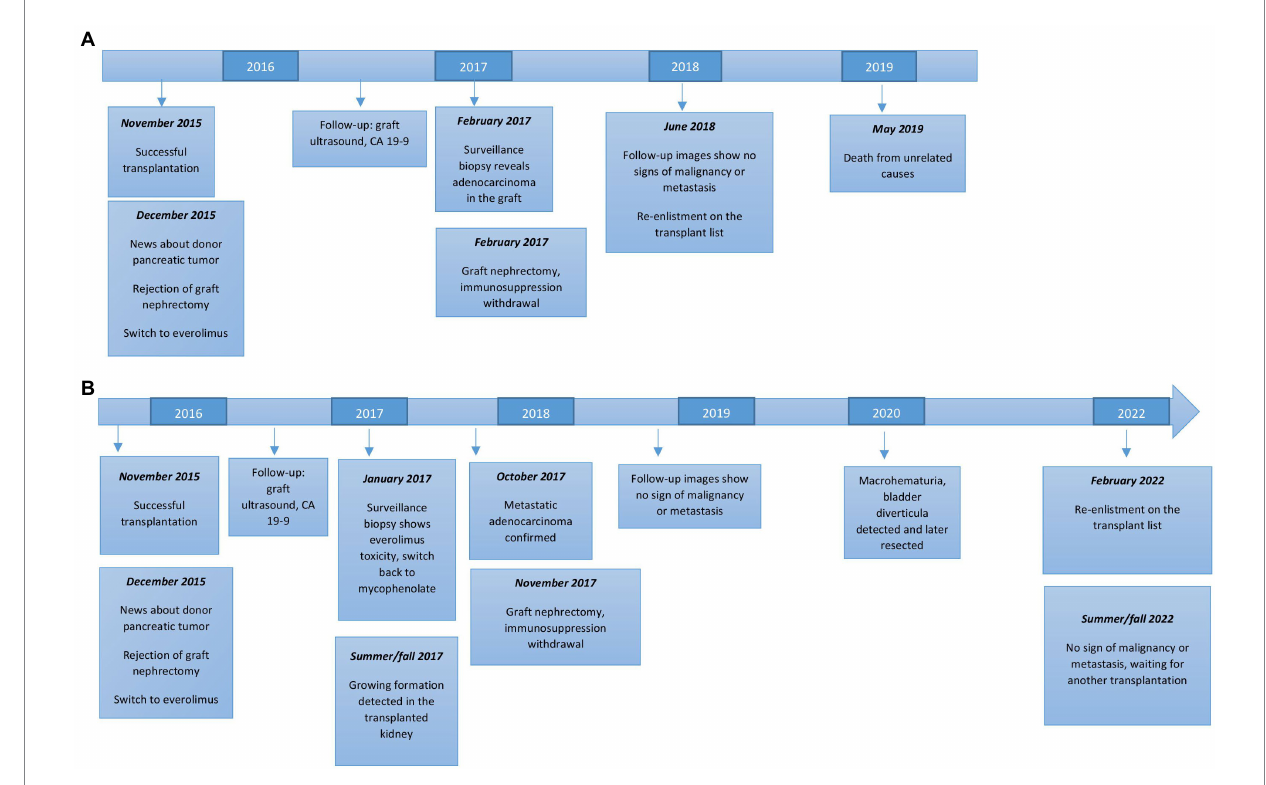
FIGURE 1 Timing of major events in both kidney transplant recipients. (A) Recipient of the right kidney. (B) Recipient of the left